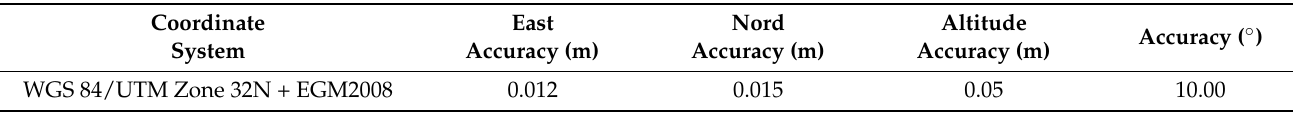
Table 4. Coordinate system and accuracy